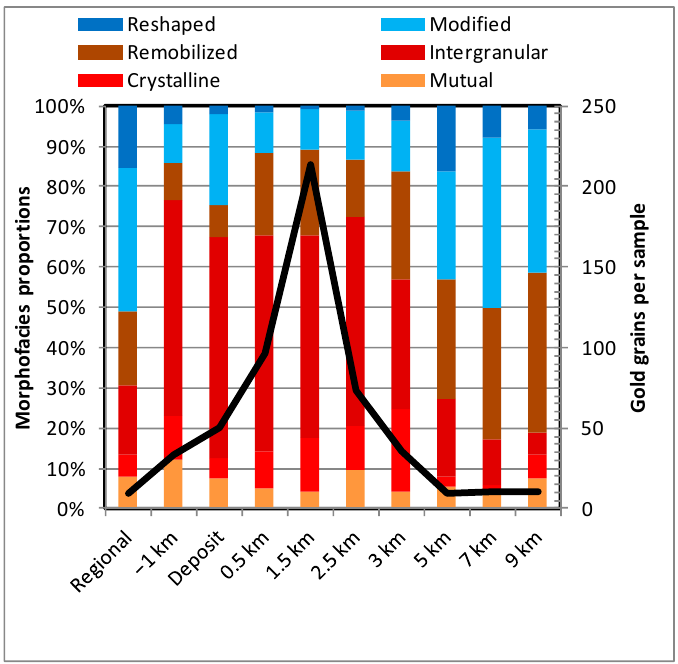
Figure 13. Relative proportions (% of grains) of each morphofacies (red hues are pristine, blues are modified or reshaped) down-ice of the Borden gold occurrence [13], as measured on the regional survey and along the various sampling fences of the orientation survey, starting 1 km up-ice from the deposit, on top of the deposit and along seven profiles located 0.5 to 9 km down-ice of the deposit. The average number of grains per samples for each profile is indicated by the black line (right scale). The regional samples contain 49% pristine grains, a typical proportion of most regional survey. This proportion sharply increases to 75–89% from slightly up-ice to 3 km down-ice of the deposit, to resume near to the regional level further south.